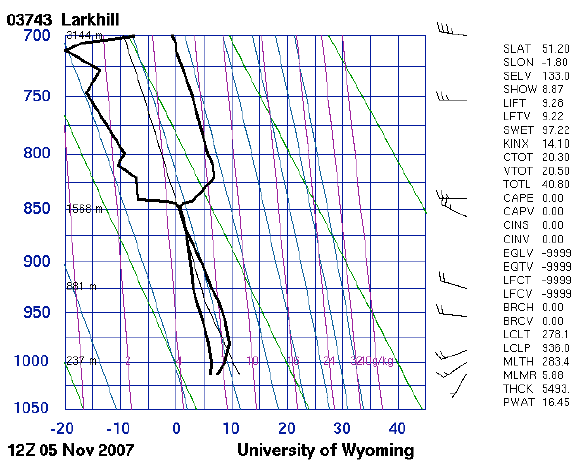
Fig. 5. Stuve diagram showing Larkhill sounding at 12 UTC, 5 November 2007. Plot courtesy of Department of Atmospheric Sciences, University of Wyoming